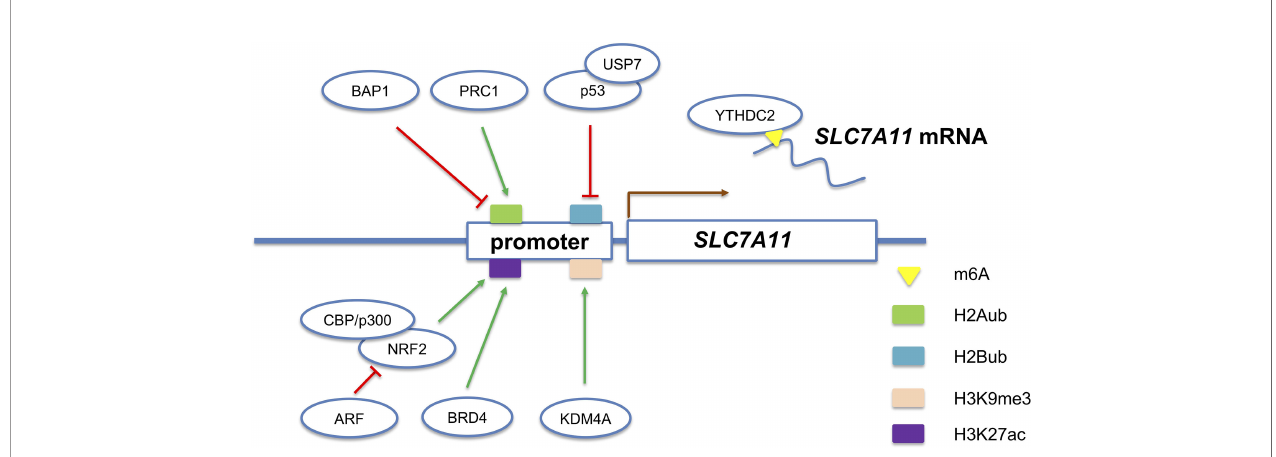
FIGURE 1 | Multiple epigenetic mechanisms regulate the expression of SLC7A11 gene, a representative ferroptosis-associated